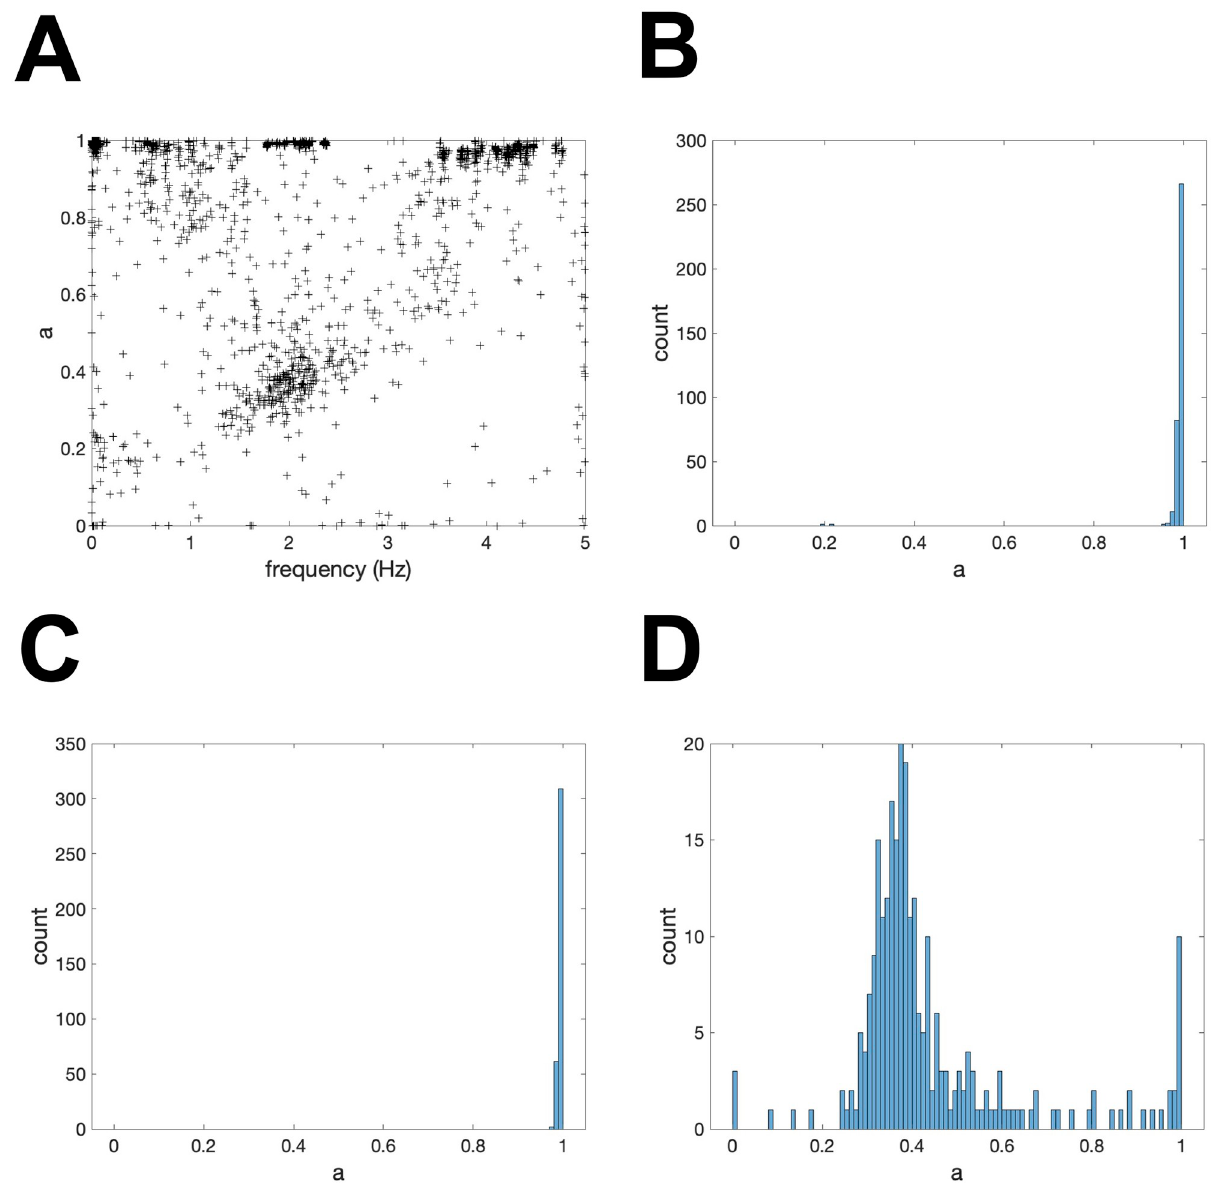
Fig 14. (A) Scatter plot of the frequency f k and parameter a k of the extracted oscillators. (B) Histogram of the parameter a k for the brain oscillators. (C) Histogram of the parameter a for the pulse wave oscillators. (D) Histogram of the parameter a k